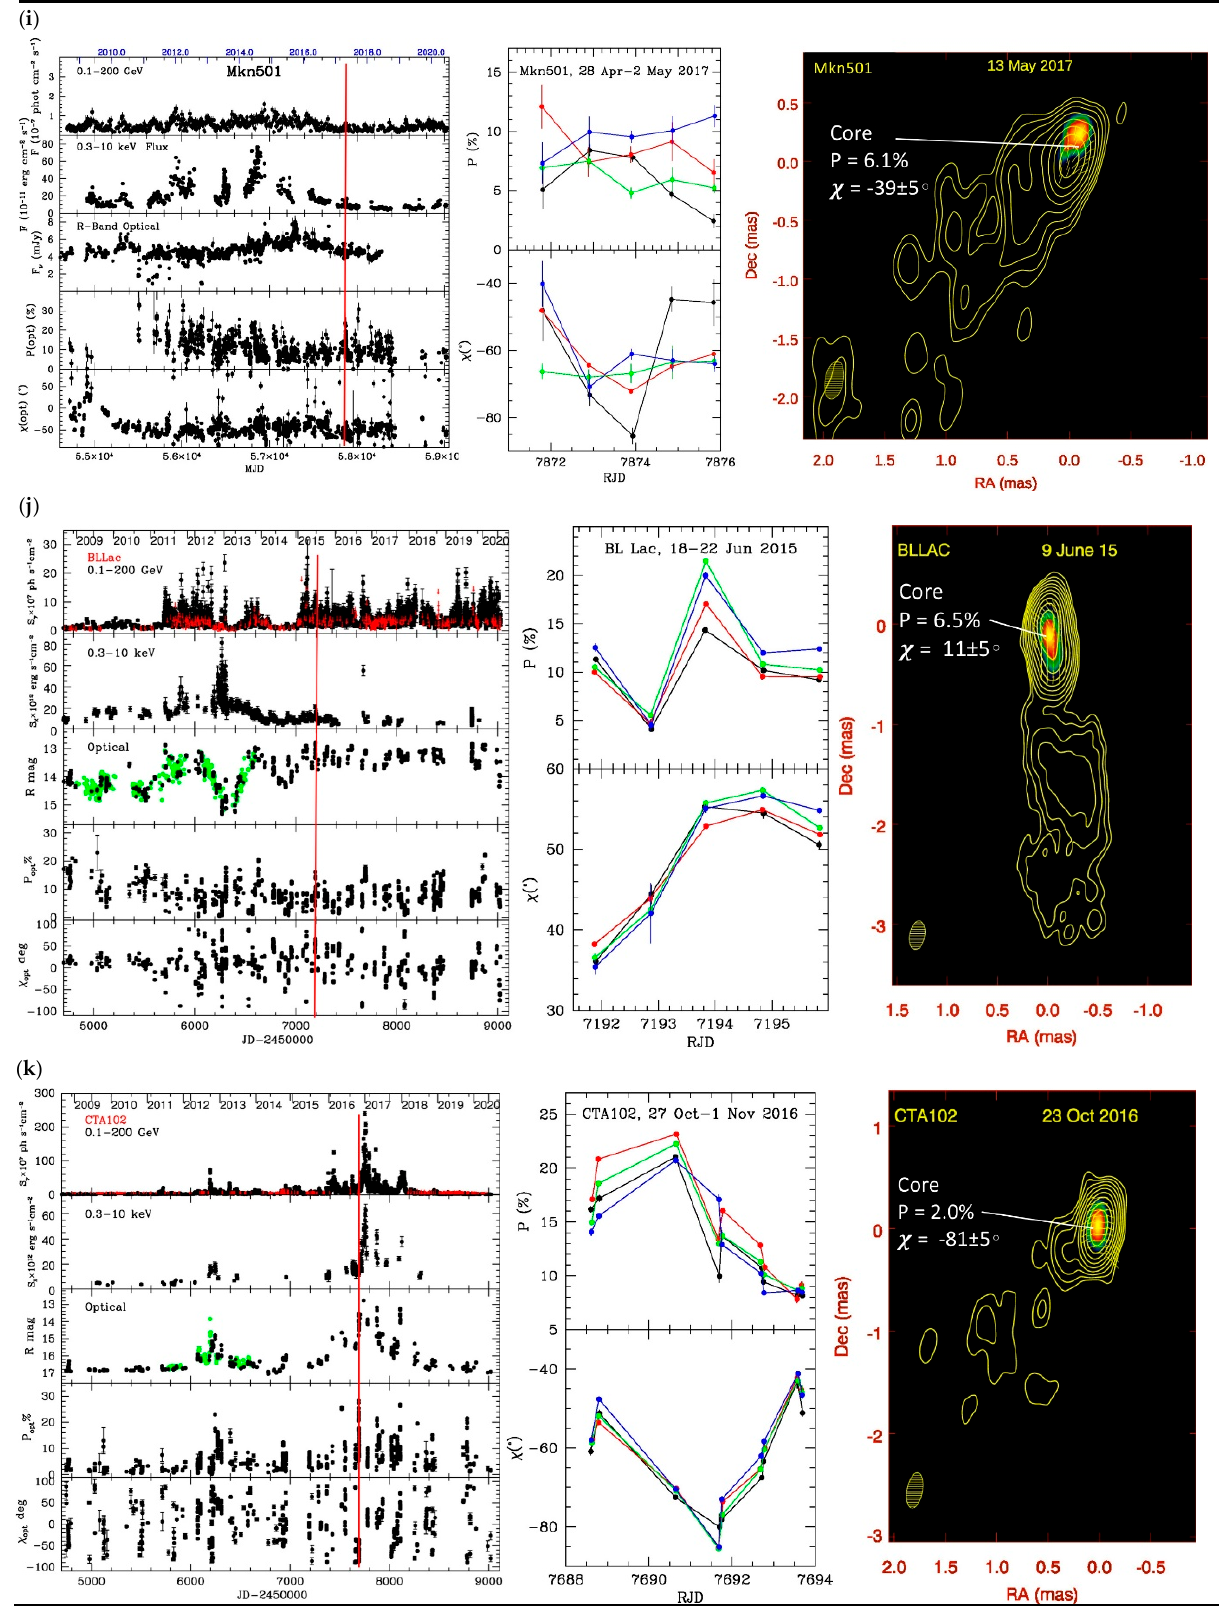
Figure 1. Observations of the blazars ( a ) 3C 66A, ( b ) 0716 + 714, ( c ) OJ287, ( d ) 0954 + 658, ( e ) Mkn421, ( f ) 1156 + 195, ( g ) 3C 279, and optical polarization vs. time (red points in the 0.1–200 GeV light curves are upper limits). (Middle) optical